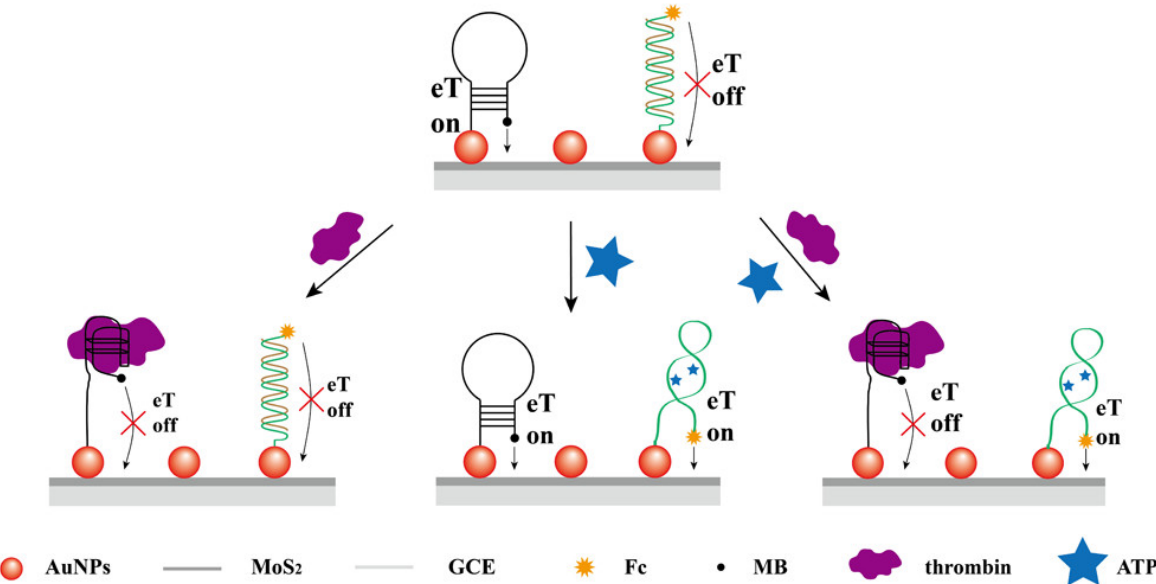
Figure 11. Schematic representation for the development of the aptasensor for the determination of ATP and thrombin. Reprinted with permission from Ref. [78] . Copyright 2016, ACS. ATP and thrombin. Reprinted with permission from Ref. [78]. Copyright 2016,